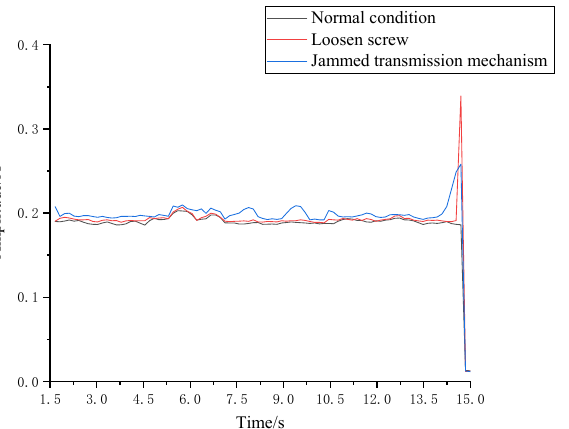
Figure 2. The envelopes of the stator fundamental current from the start of opening to the end of opening under the three operating conditions.